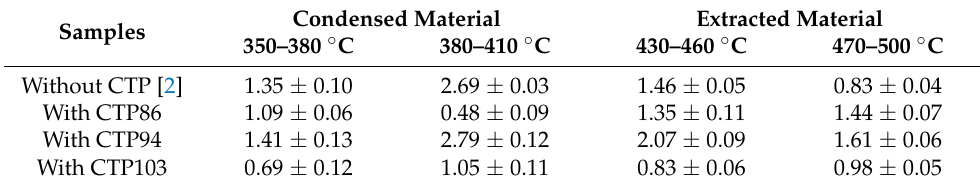
Table 3. The yield of the material extracted from the zones of plastic layer.